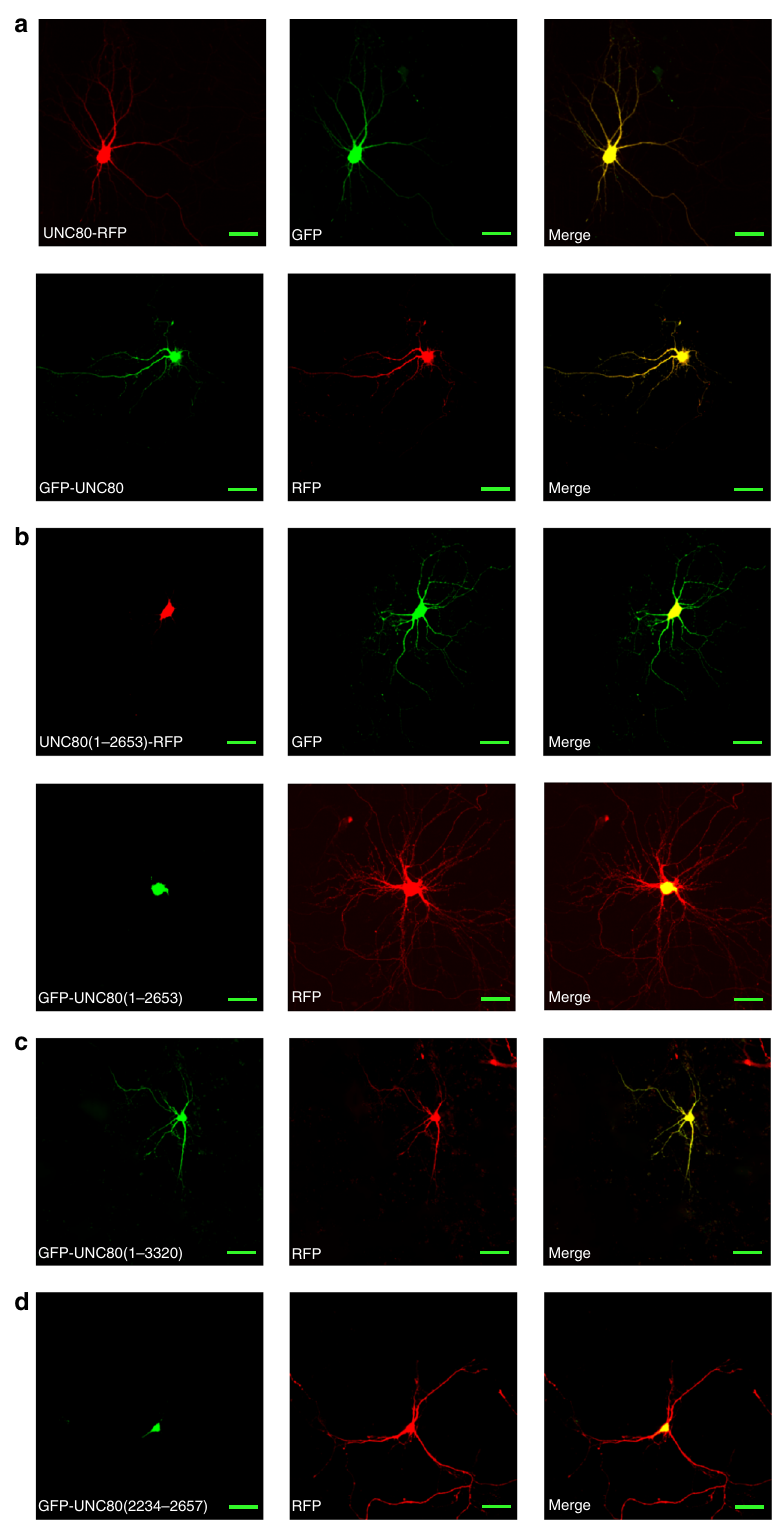
Fig. 7 UNC80 ’ s C-terminal domain overcomes soma-retention for dendritic localization. a C-terminally RFP (upper) or N-terminally GFP (lower)-tagged UNC80 was co-transfected with GFP (upper) or RFP (lower) into cultured wild-type hippocampal neurons. Scale bars: 50 μ m. b – d Similar to ( a ) but transfected with UNC80 mutants truncated at L2654 (containing residues 1 – 2653) ( b ), lacking the last six residues (containing residues 1 – 3320) ( c ) or containing residues 2234 – 2758 only ( d ). Representative pictures from similar results of >10 are presented for each